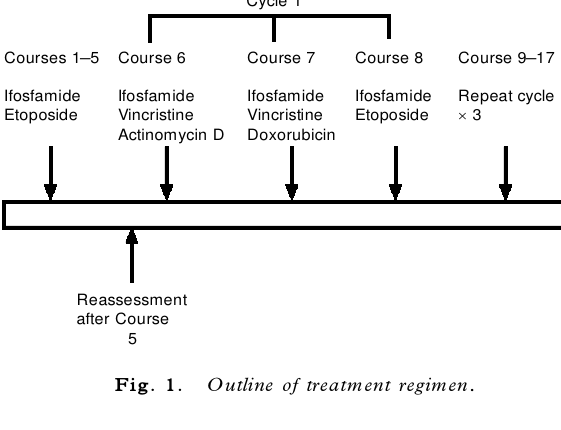
Fig. 1. Outline of treatment regimen